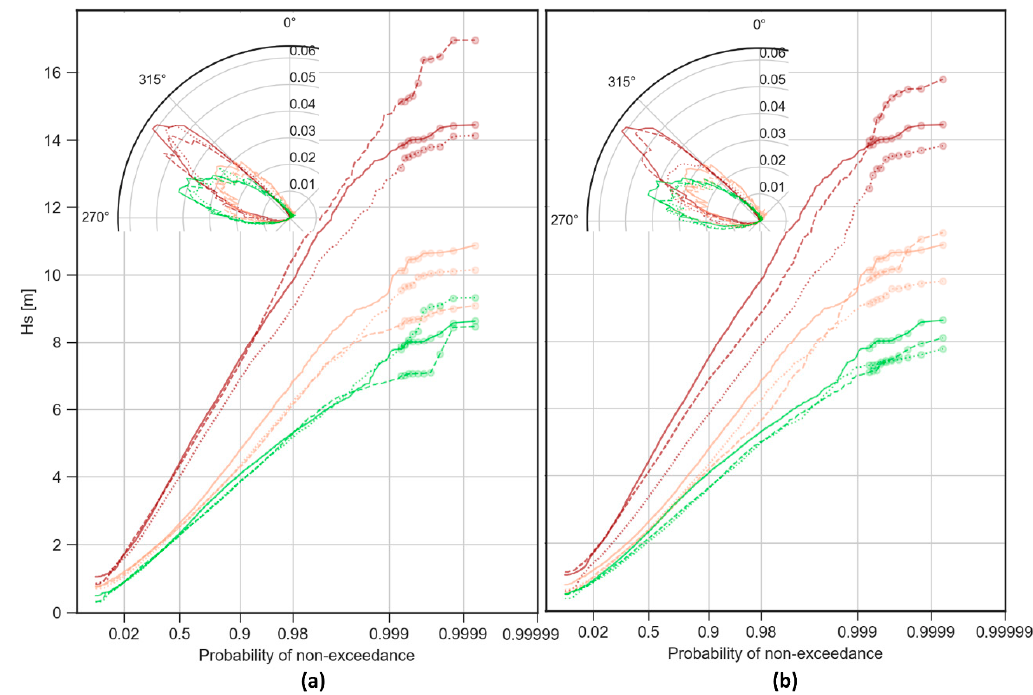
Figure A4. CDFs of the propagated values of H S at deep waters (winter dataset) with a detail of the polar PDFs of wave directions for: ( a ) Control simulations and short-term simulations (2026–2045) of all models and concentration scenarios; ( b ) Control simulations and long-term simulations (2081–2100) of all models and concentration scenarios.